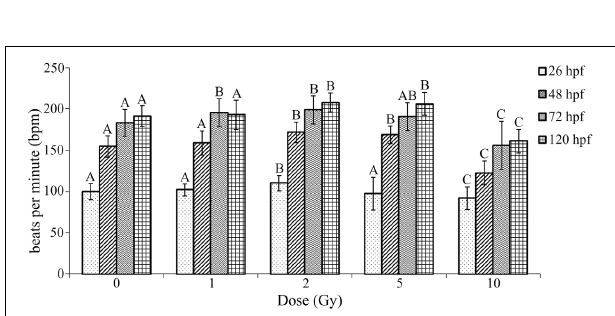
lower doses for CACNA1D (A) , GUCY1B3 (B) , NTRK3 (C) , PBX3 (D) , or PTPRE (E) . A significant decrease in expression was observed at both 1 and 2 Gy for LIN7B (F) . ( n = 5; ∗ p < 0 . 05; error bars depict standard deviation).